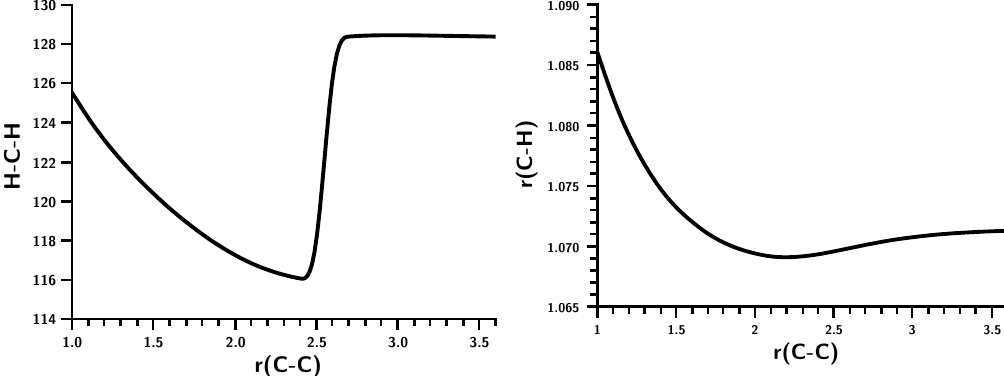
Figure 4. Carbene dimerization. HCH bond angle and CH bond length. Angles in degrees; bond lengths in